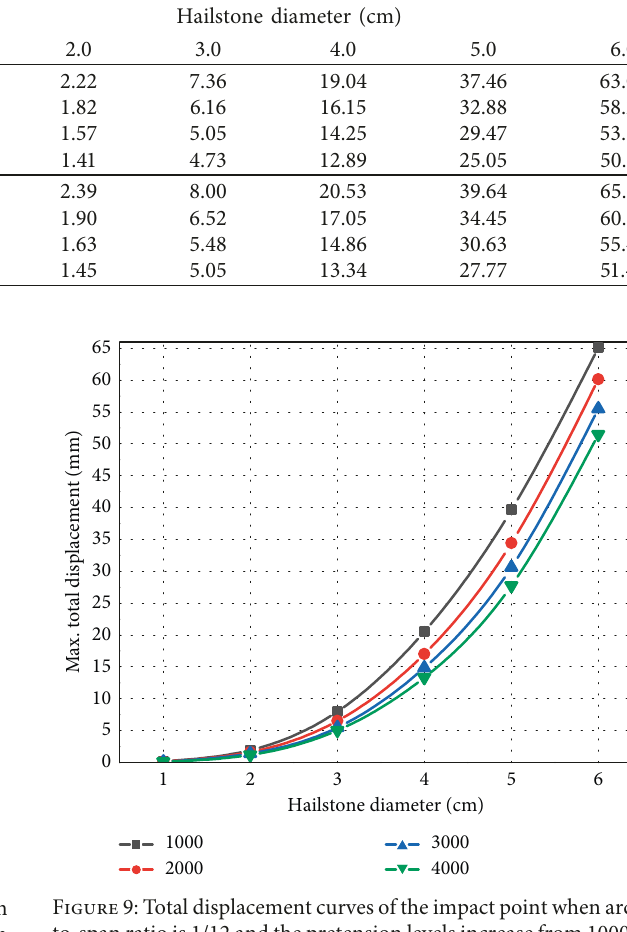
Table 3: Max. total displacement values (mm) of the impact point.